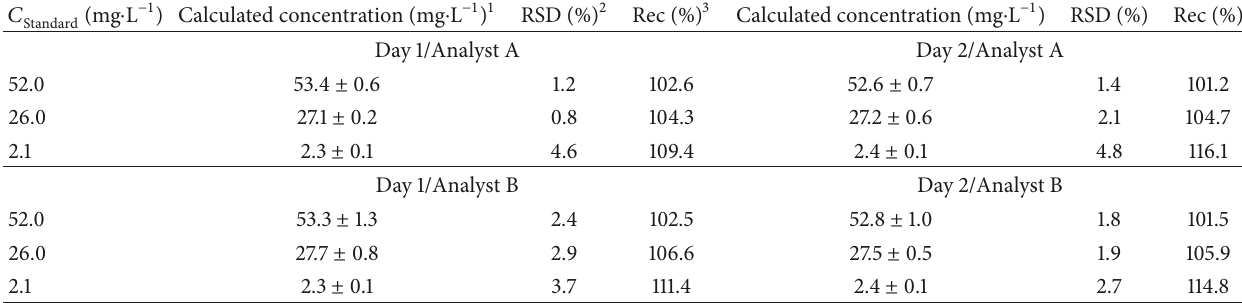
Table 2: Repeatability evaluation and intermediate precision results.